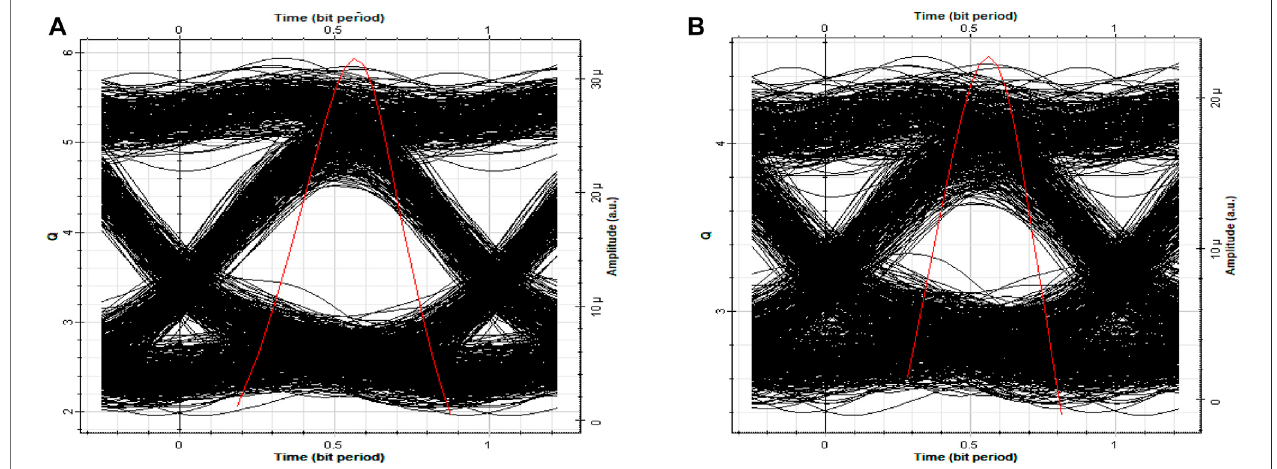
FIGURE 12 | Eye diagram using the proposed NRZ-based MDM-RoFSO link at 108 m transmission distance under dense dust for the (A) HG00 channel and (B) HG01